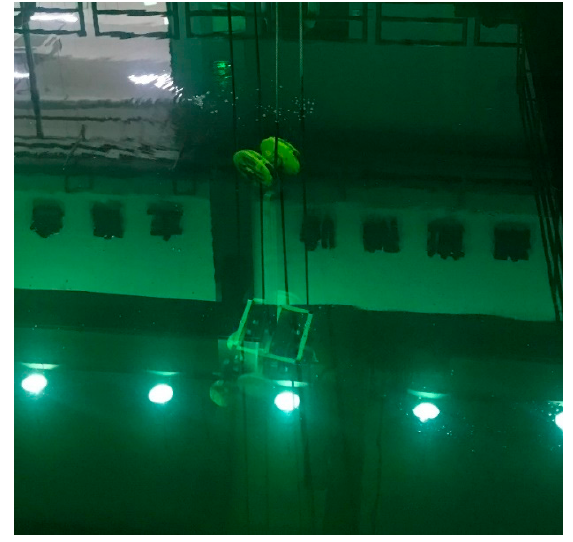
Figure 19. The hydrostatic seal test.